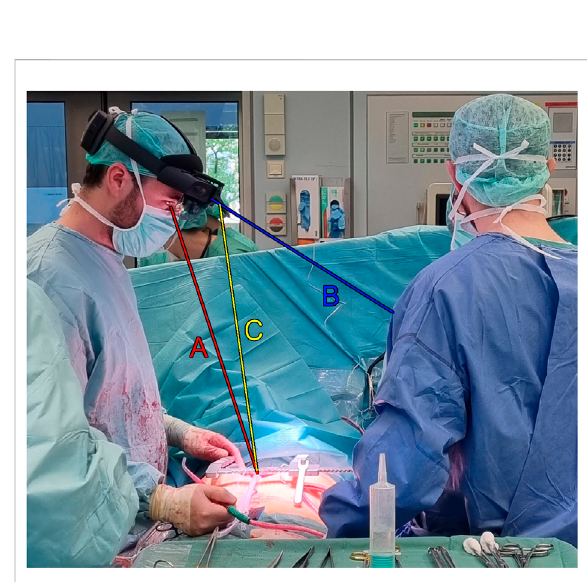
FIGURE 2 A surgeon wearing the HL2 with attached MirrorMount in the OR capturing scenes of an open-heart surgery in a typical posture during surgery. (A) shows the viewing axis of the surgeon, (B) the RGB camera axis and (C) the camera axis re fl ected by the mirror